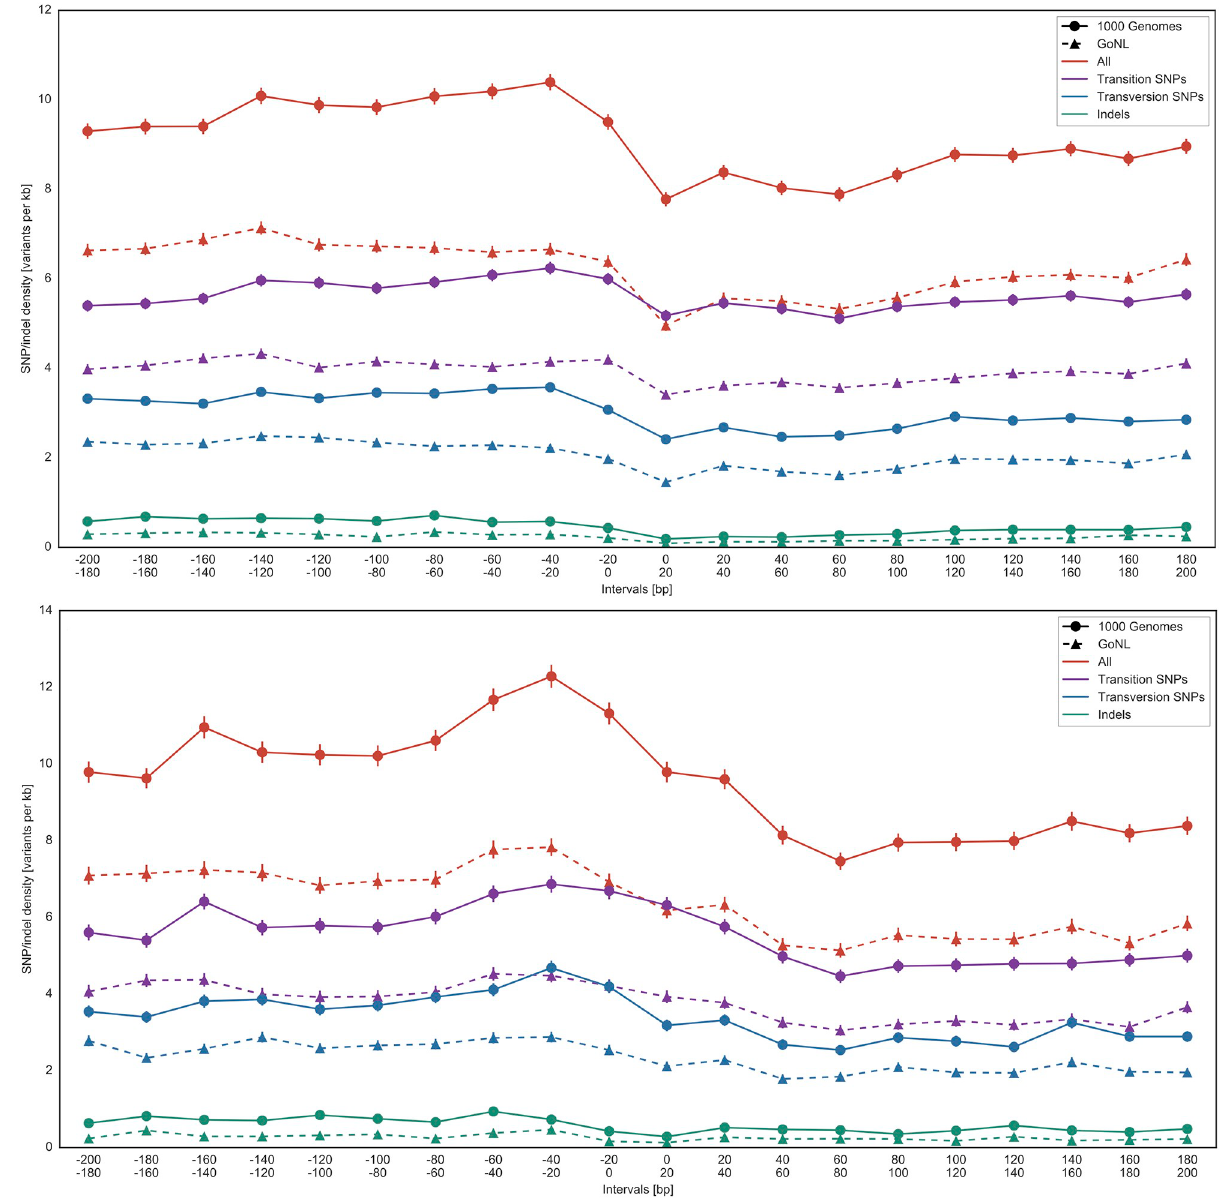
Fig 5. SNP distribution around the coding start site (CSS). Average SNP density in a range of ± 200 bp and 20 bp windows around the CSS (1000G and GoNL data). Upper panel: annotated translation start sites of (RefSeq genes); Lower panel: alternative translation starts detected by ribosome profiling applied to HEK293 cells. The standard error of the mean is visualized for every datapoint.